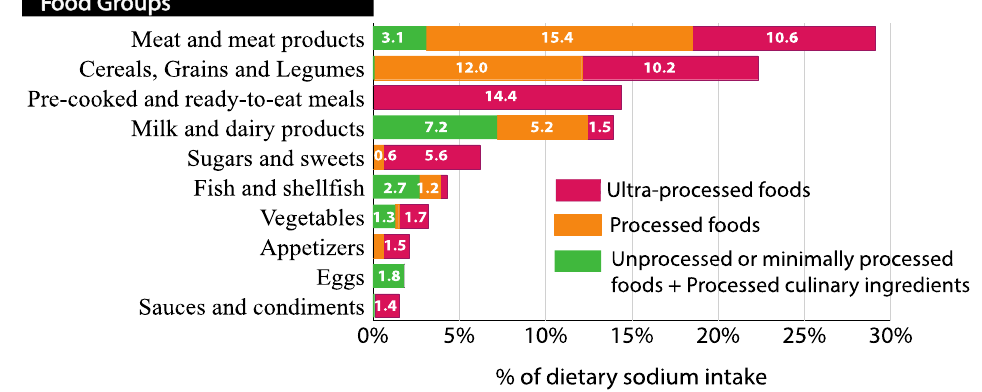
Figure 3. Sources of dietary sodium based on the degree of processing of food (NOVA classification) ( n = 321) [22,28,29]. Contribution of the sodium content in different food groups to the total sodium dietary intake. Food groups and dietary sodium intake were derived from a 3-day food record. Foods were classified based on the degree of processing according to the NOVA system. They were organized into three groups in this figure: unprocessed or minimally processed foods + processed culinary ingredients, processed foods and ultra-processed foods. The sodium contribution was expressed as a percentage of the total dietary sodium intake.